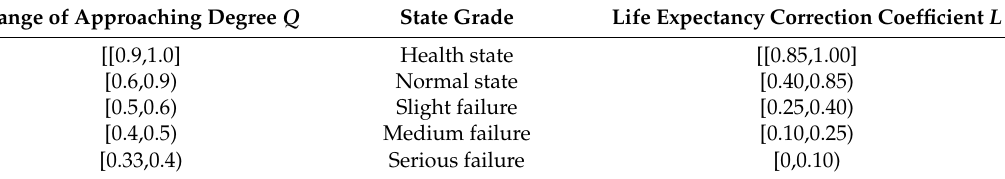
Table 2. Corresponding relationship between the state grade and life expectancy correction coefficient of transformer oil-paper insulation system